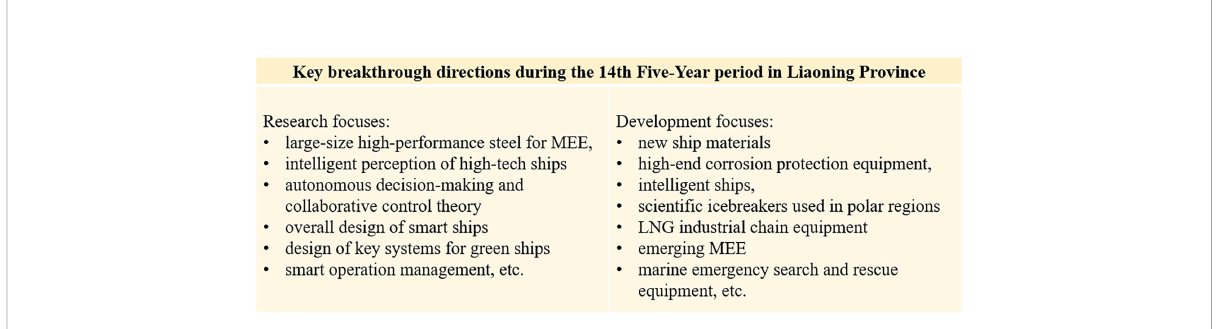
FIGURE 4 Key breakthrough directions during the 14th Five-Year period in Liaoning Province. Source: Authors ’ compilation based on MEE policies in Liaoning Province ’ s 14th Five-Year